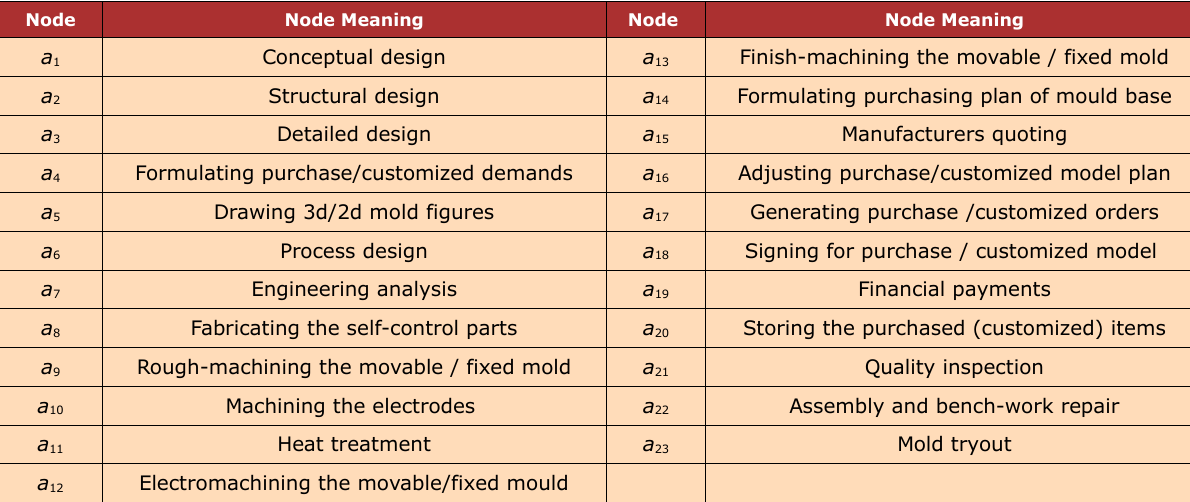
Table 1. Active node definitions